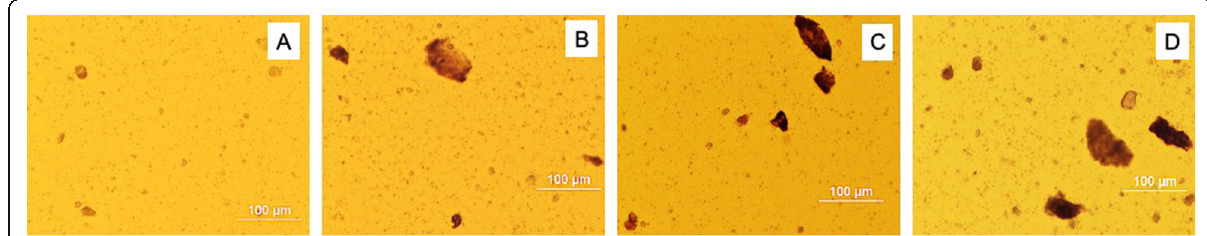
Fig. 7 Optical light microscope images at 200x magnification depicting the microstructures of diluted feed dispersions with 1.0 SPI:sucrose with 0% ( A ), 0.5% ( B ), 1% ( C ), and 1.5% PP addition ( D